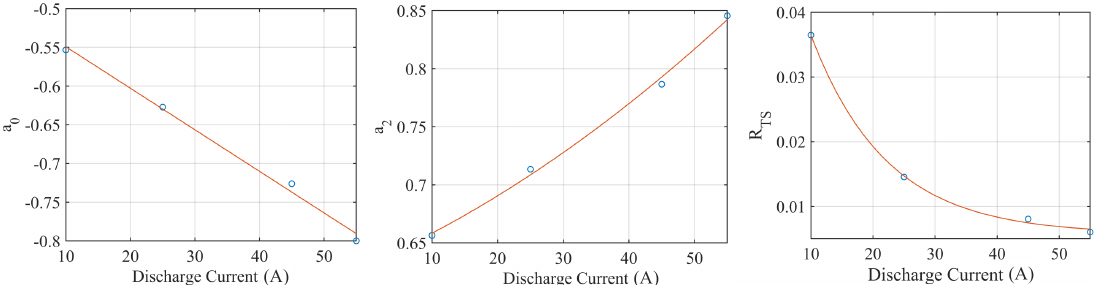
Figure 6. Parameters’ trends for Li-ion, C = 100 Ah: a 0 and a 2 are represented by a polynomial; R TS is fitted by means of an exponential